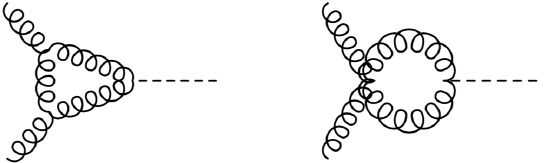
Figure 3 . QCD one loop contribution to G G → h